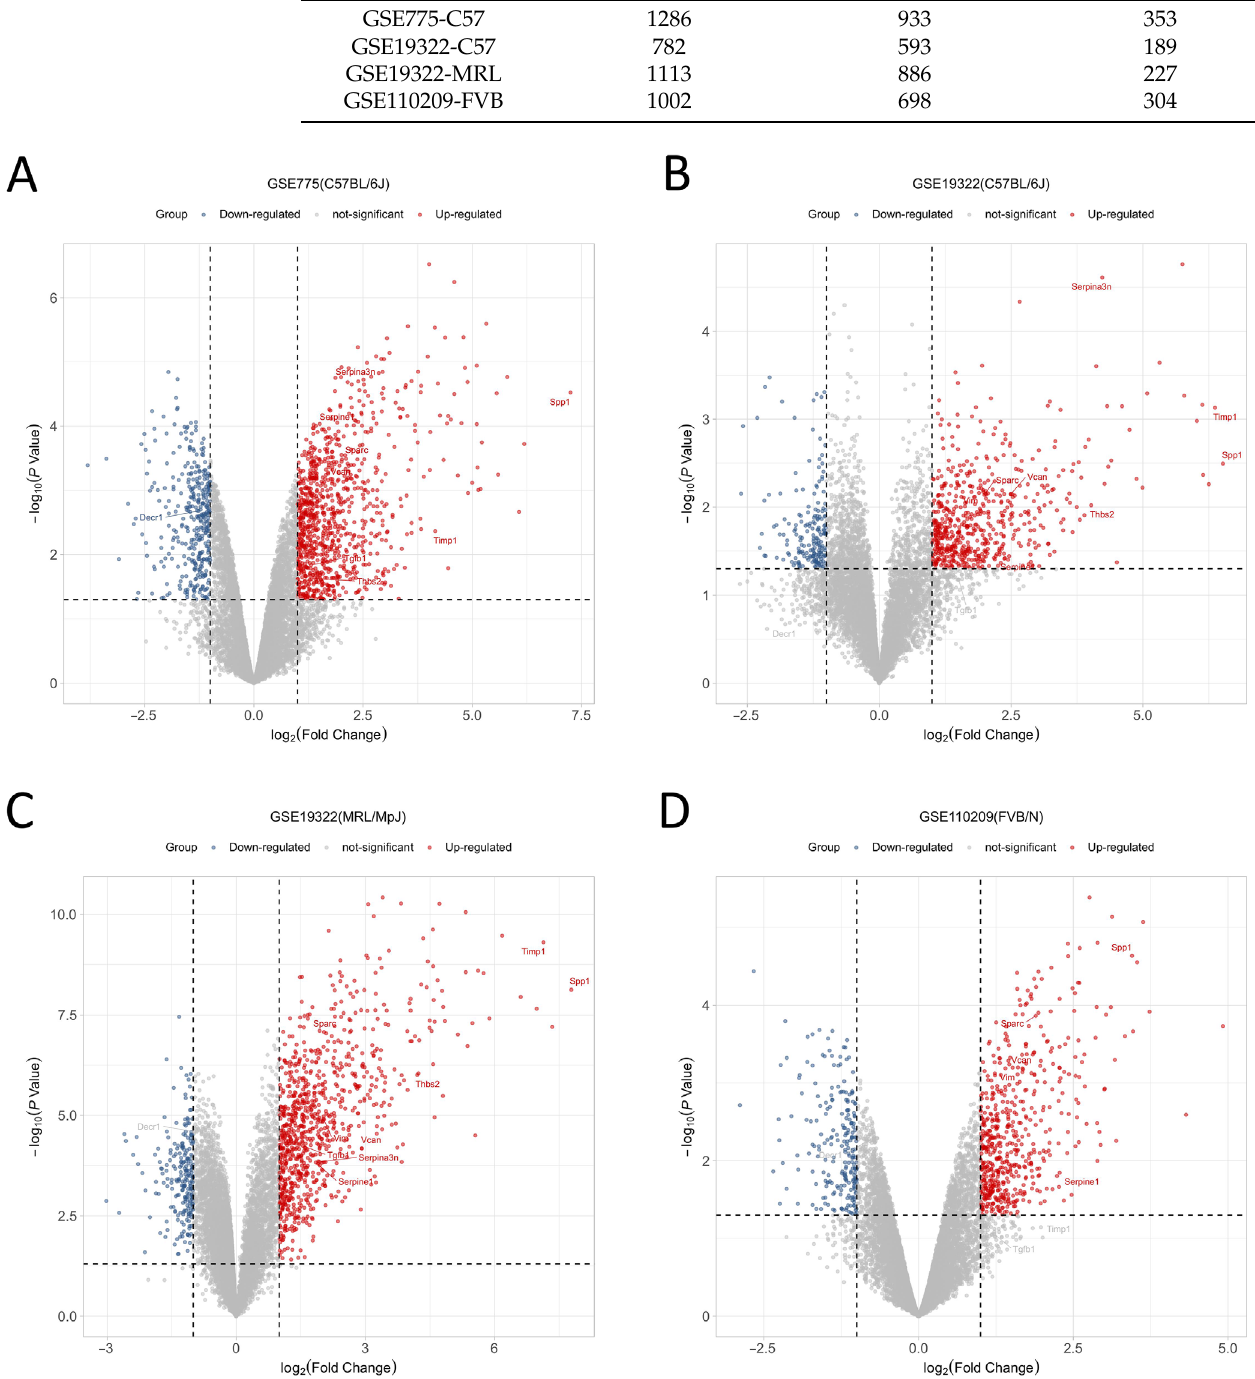
Figure 1. Volcano plot of DEGs from the 4 groups. ( A ) Volcano plot of group GSE775-C57; ( B ) Volcano plot of group GSE19322-C57; ( C ) Volcano plot of group GSE19322-MRL; ( D ) Volcano plot of group GSE110209-FVB; Blue points represent down-regulated genes, red points represent up-regulated genes, and gray points represent genes showing no significant difference in expression between conditions (threshold for significance: |log 2 FC| > 1.0 and p < 0.05). Hub genes are